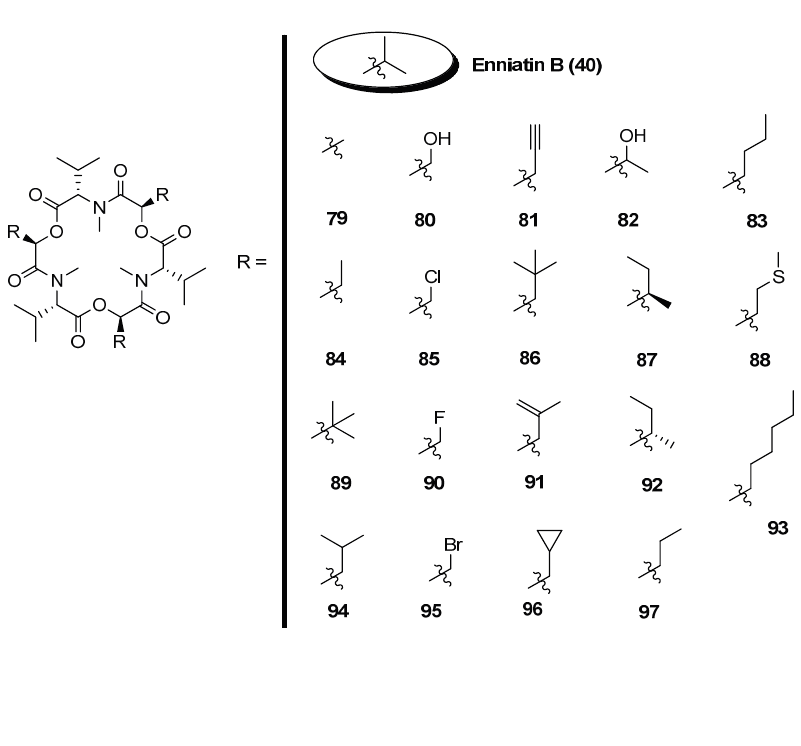
Figure 8. In vitro synthesis of hydroxy acid derivatives of 40